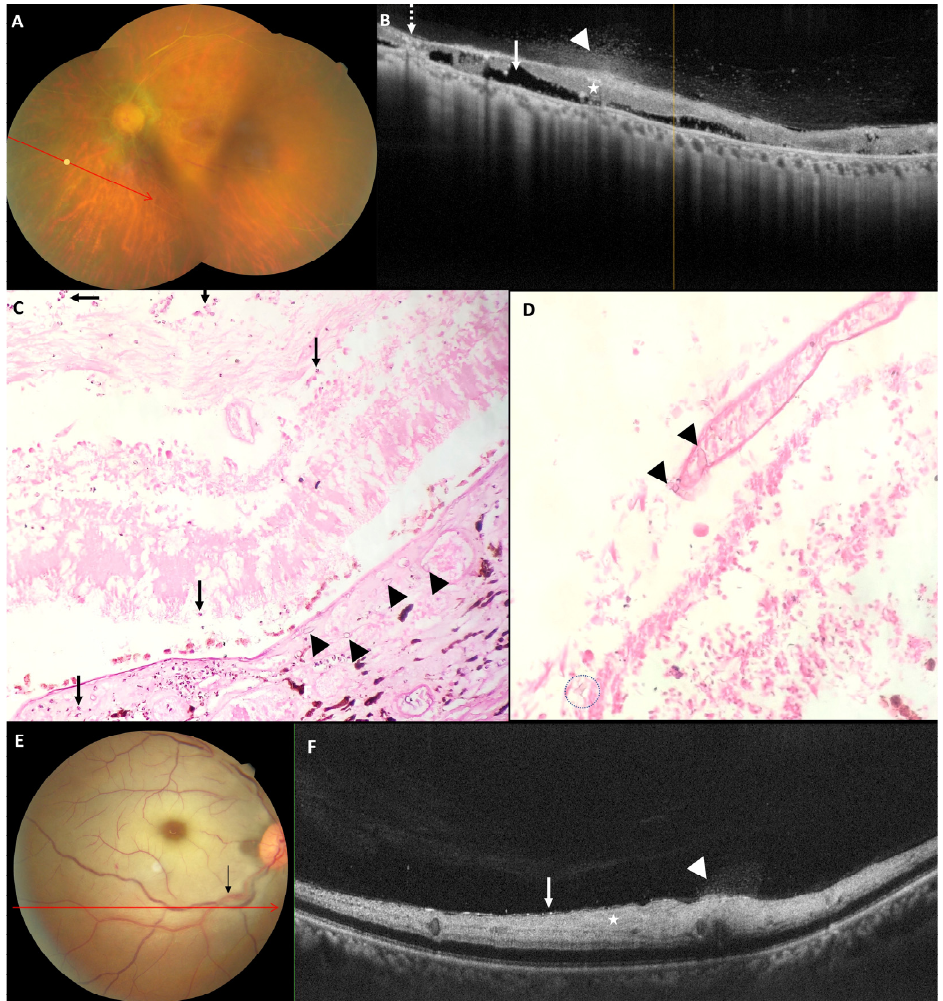
Figure 5. Fundus photograph, SD-OCT images having nasal vascular arcade cross-section and histopathological morphology of a representative case (case 12) at sixth week of follow up: ( A ) Colour fundus photograph montages shows sclerotic retinal arteries with boxcar segmentation, fibrous scarring ( B ) SD OCT images showing disruption of all retinal layers (white star), optically empty spaces (white arrow) (necrotic spaces), focal chorioretinal scarring (white dotted arrow) and vitreous cell and haze (white arrow head) (vitritis) overlaying thickened hyaloid. Photomicrograph shows ( C ) mucor hyphae in choroid along with angioinvasion of choroidal blood vessel (black arrowhead). Neutrophilic infiltrate (black arrow) present in choroid as well as in necrotic layer of retina (H&E; 200×). ( D ) Necrotic retinal tissue with presence of mucor hyphae (dotted circle) and disrupted normal lamellar architecture. Blood vessel showing angioinvasion by mucor hyphae (black arrowhead) (H&E; 400×). Fundus photograph, SD-OCT images of temporal vascular arcade of another representative case (case 8) at presentation ( E ) Colour fundus photograph suggestive of retinal infarction and oedema with haemorrhage along inferior temporal artery (black arrow). ( F ) With SD-OCT showing signs suggestive of retinal infarction including increased inner retinal thickness and hyperreflectivity (white star), presence of subtle internal limiting membrane detachment (white arrow), along with the sign of inflammatory response, vitreous haze and cell overlaying the vascular arcade (white arrow head), secondary to possible angioinvasion.